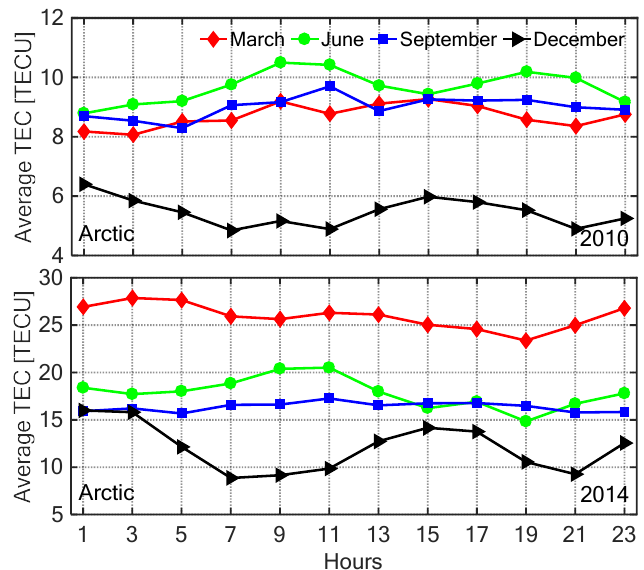
Figure 13. Mean diurnal variations of the C0,0 and the global ionospheric map (GIM) TEC in the Arctic ( top ), Antarctic ( middle ), and the time series of the solar activity index of F10.7 ( bottom ).